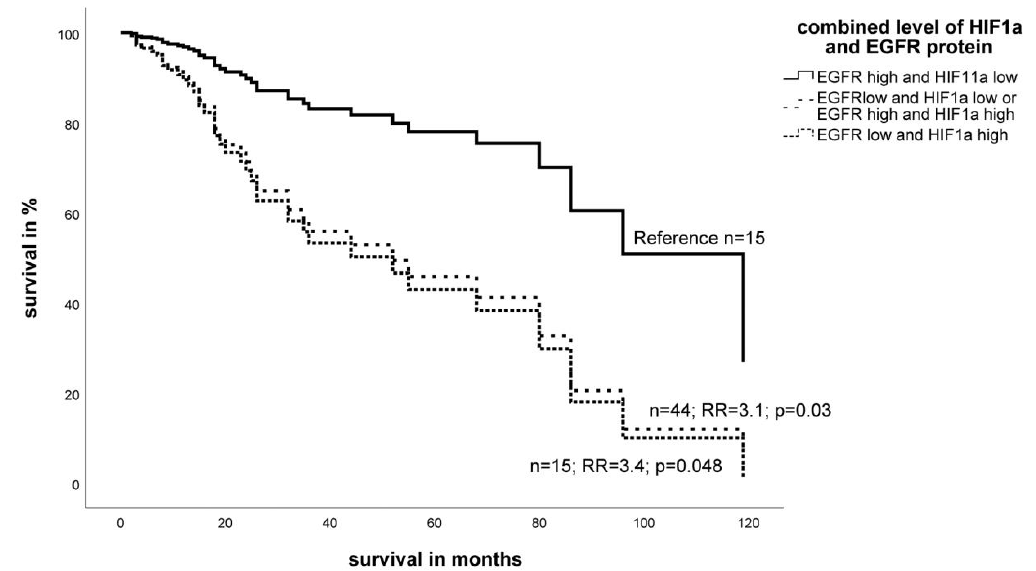
Figure 6. Multivariate Cox’s hazard regression model for the combination of HIF-1 α and EGFR protein expression and tumor-specific survival in STS patients. The expression of HIF-1 α protein and EGFR protein for 74 STS patients was associated with survival. The model was adjusted for tumor stage, tumor localization, tumor entity, and the type of tumor resection. A low HIF-1 α protein and a high EGFR protein level in the tumor resulted in a significantly better prognosis in STS patients compared to that of groups II and